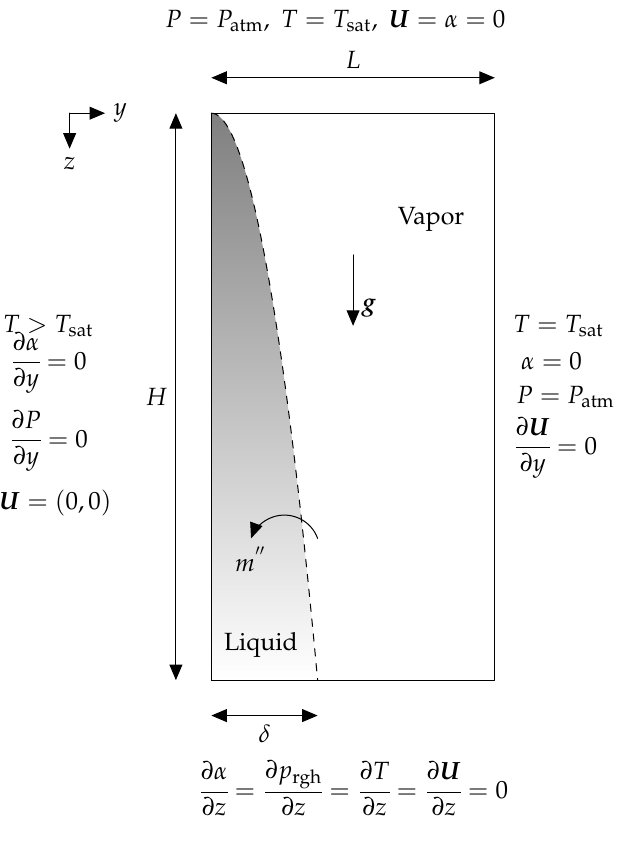
Figure 8. The condensation of a laminar film on a vertical plate is shown schematically, together with the associated boundary conditions. Gray denotes liquid, but white denotes a geometric area filled with vapor. As seen by the dashed line, the phase change occurs at the gas–liquid interface. When the vertical wall cools below superheat, phase change occurs. The condensation phase change described above results in the formation of a layer of condensed liquid in the shape of a parabola on the left wall.